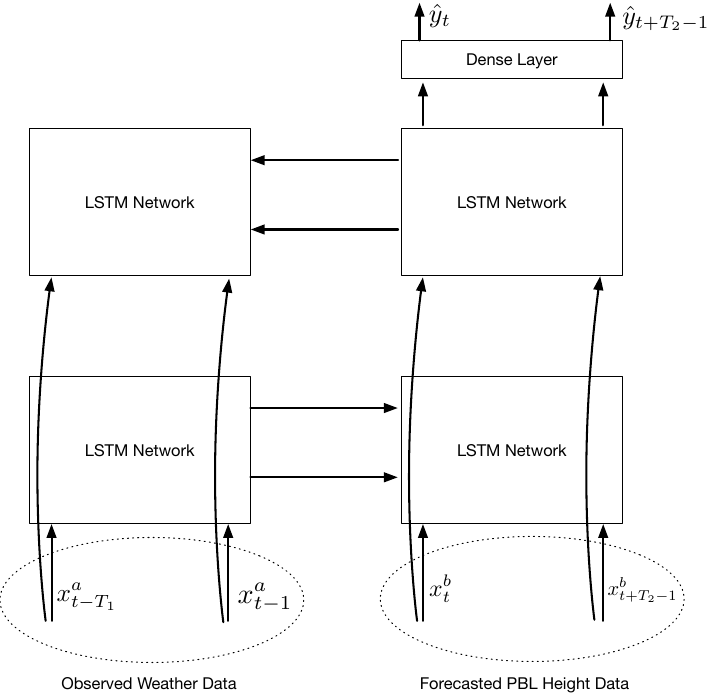
Figure 3. Proposed ozone forecast model based on the bidirectional LSTM